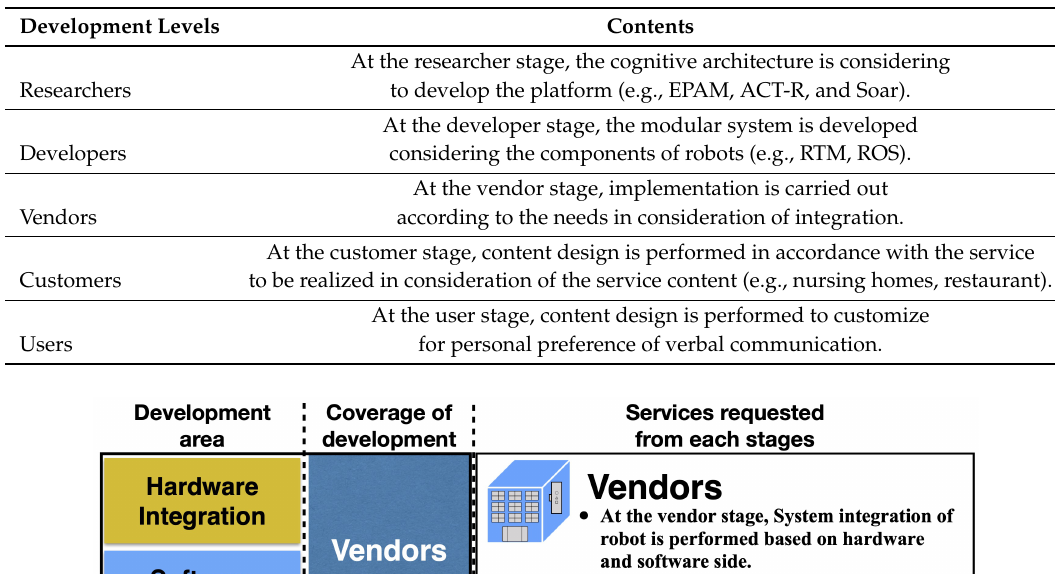
Table 1. Development at various levels for customization.